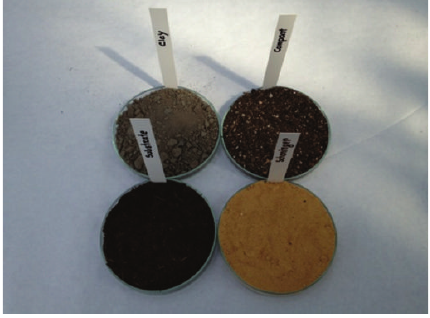
Figure 3: Components used for soil